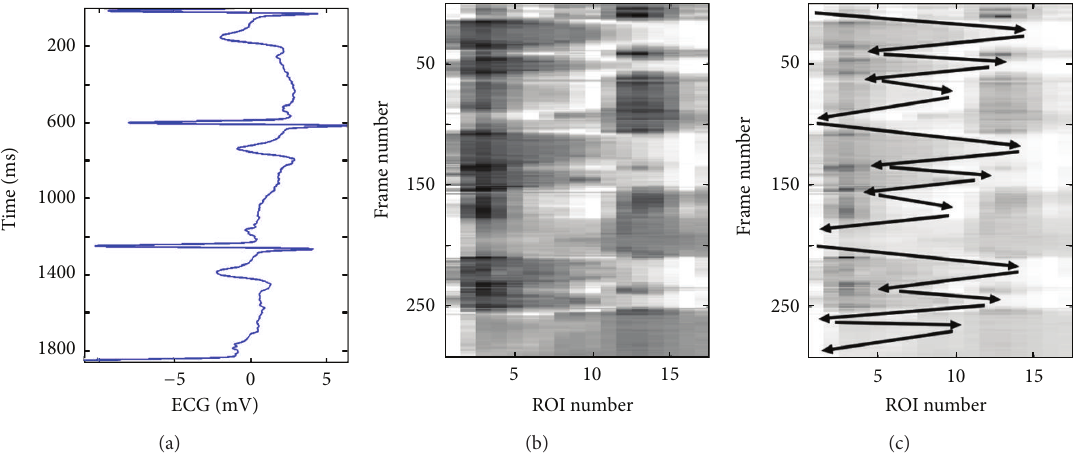
Figure 7: Spatiotemporal wave representation corresponding to the same healthy young case Y1 shown in Figure 6. The ECG signal is shown to the left (a) and the spatiotemporal 2D map is shown to the right (b). The longitudinal motion, across neighboring ROIs, is marked by black arrows on the spatiotemporal 2D map